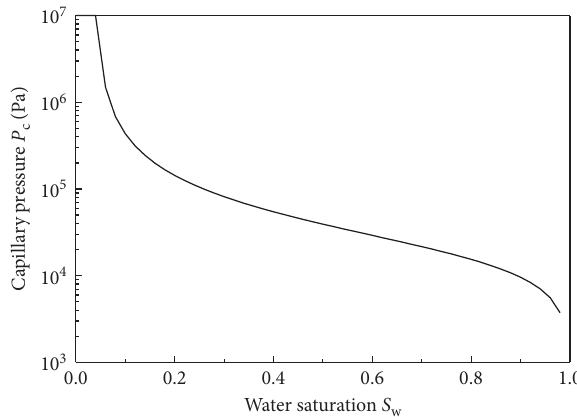
Figure 10: Capillary pressure